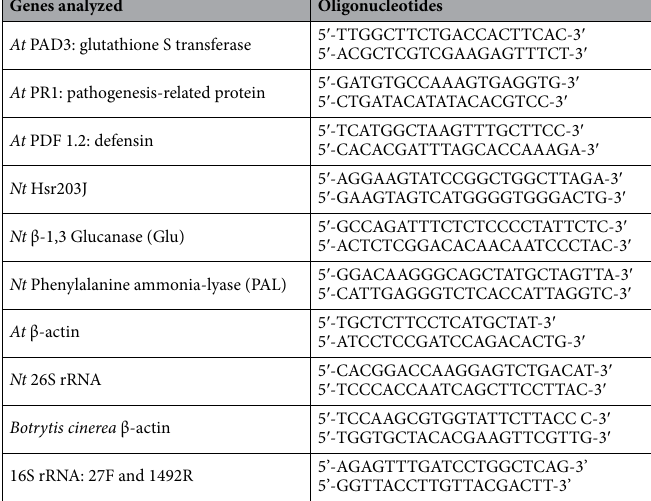
Table 1. Oligonucleotides used in the